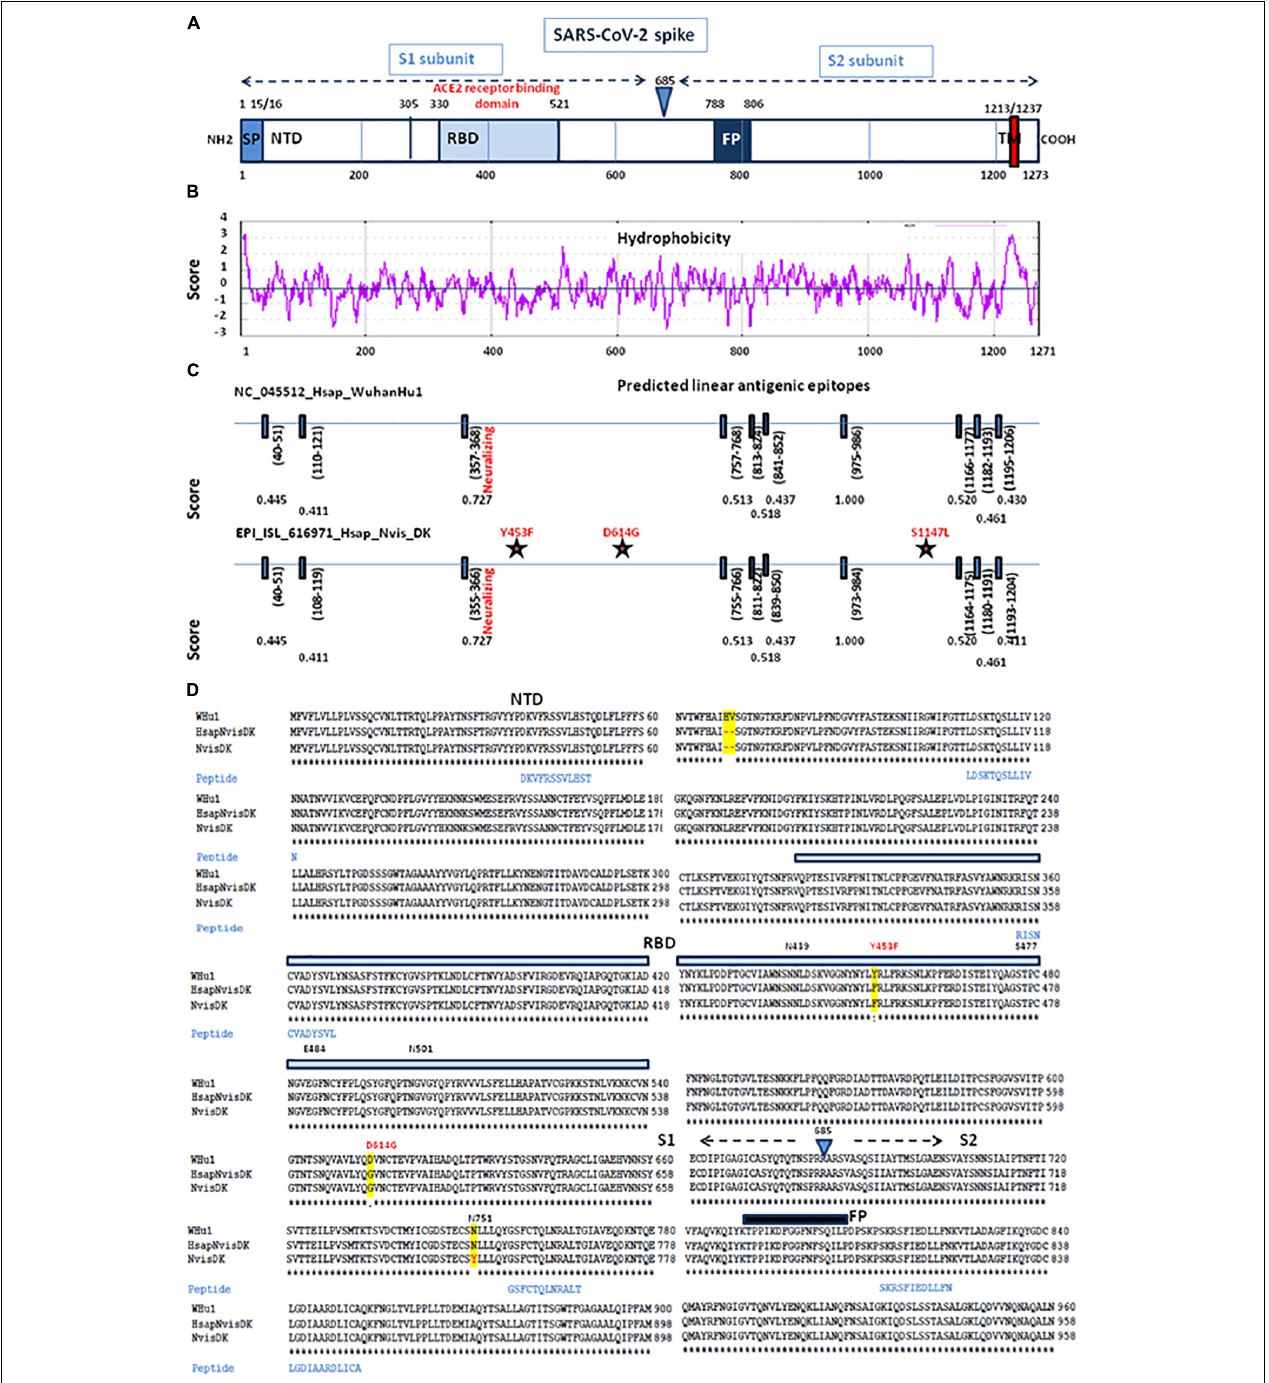
FIGURE 9 | Comparative antigenicity of human and mink SARS-CoV-2. (A) Schematic representation of the SARS-CoV-2 spike protein domains. SP, signal peptide; NTD, N-terminal domain; RBD, receptor (ACE2) binding domain; TM, transmembrane domain. (B) Prediction of protein hydrophobicity according to Kite and Doolittle using the ProtScale program. The score of hydrophobicity is indicated. (C) SVMTrip algorithm prediction of linear antigenic epitopes (12 amino acids scan) in the spike protein of SARS-CoV-2 (NC_045512_Hsap_WuhanHu1 isolate versus EPI_ISL_616971_Hsap_Nvis_DK). The location of the predicted linear epitopes is indicated as well as the score of antigenicity (1.000 being the highest score). The stars indicate the mutations found in the mink SARS-CoV-2 variant EPI_ISL_616971_Hsap_Nvis_DK. (D) Multiple sequence alignment of the first 960 amino acids of the spike protein sequence (S1 and the proximal S2) from the NC_045512_Hsap_WuhanHu1 isolate versus EPI_ISL_616971_Hsap_Nvis_DK and EPI_ISL_641413_Nvis_DK samples and location of the predicted linear B-cell epitopes. The amino acids differing between the three sequences are highlighted in yellow. The location of the variants Y453F and D164G is shown in red. NTD, N terminal domain; RBD, receptor binding domain; FP, fusion